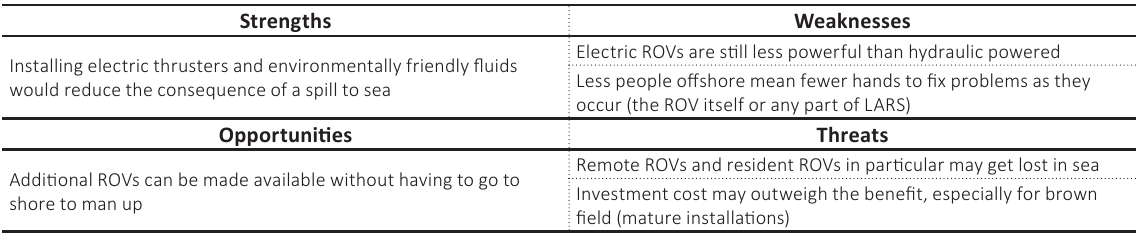
Table 5. SWOT analysis of the introduction of new ROVs systems (Operator’s